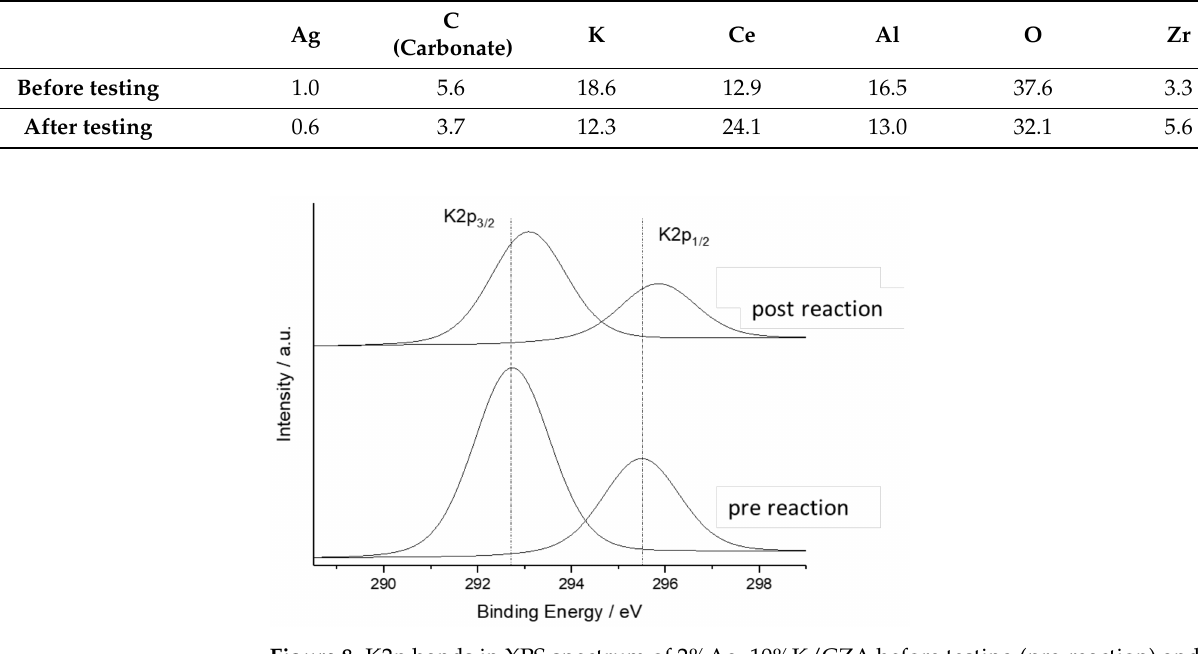
Figure 8. K2p bands in XPS spectrum of 2%Ag–10%K/CZA before testing (pre-reaction) and after testing (post-reaction) in the absence of carbon